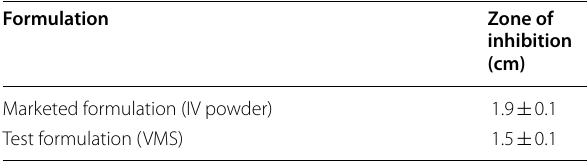
Data are represented as mean